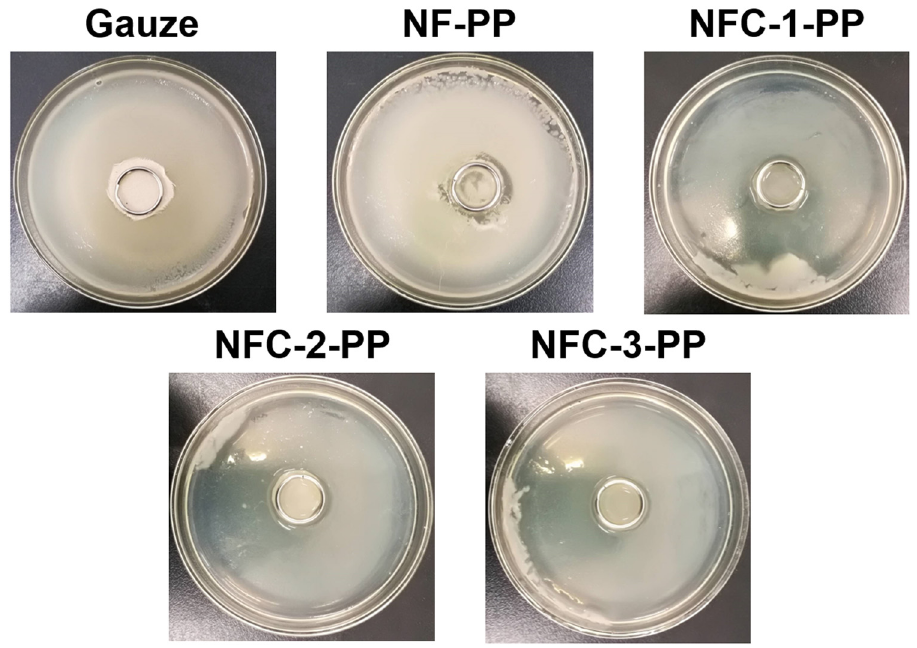
Figure 9: Antibacteria test of NF - PP and NFC - PP with di ff erent CIP concentrations.